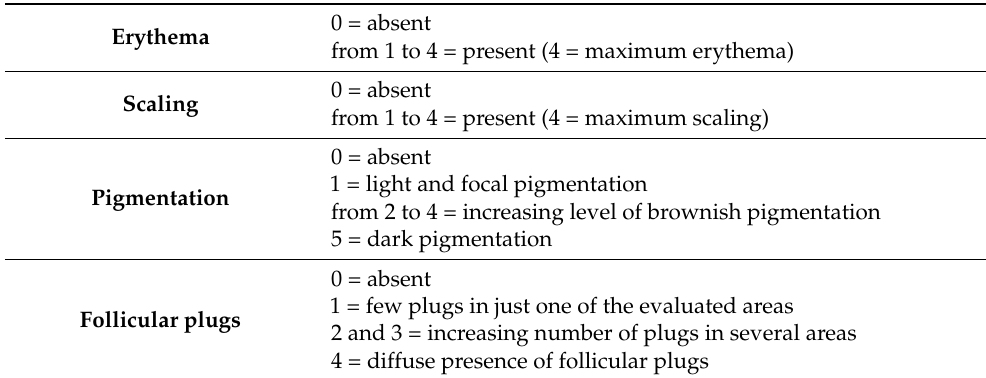
Table 3. Dermoscopic parameters used for the definition of a score for the target lesion of each patient before and after treatment.